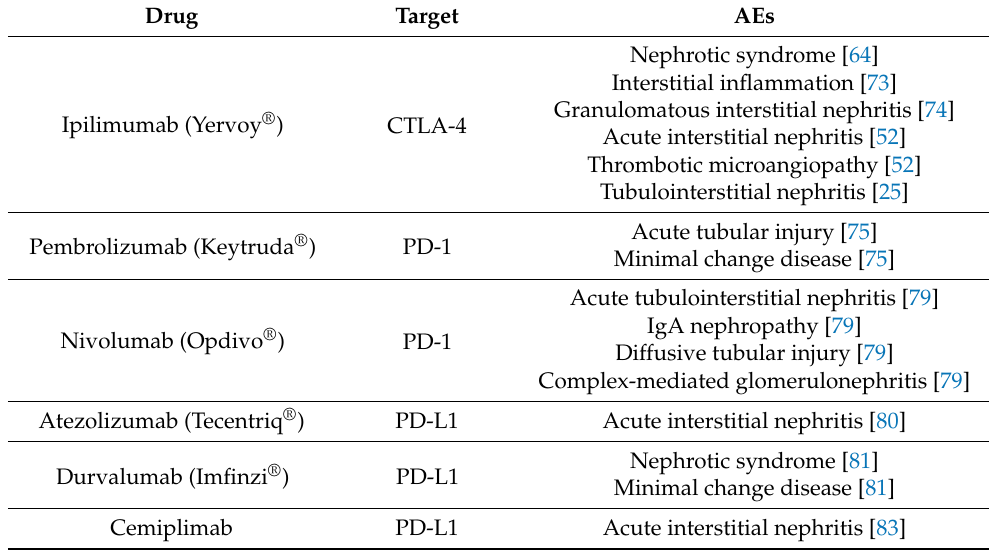
Table 3. ICI-induced